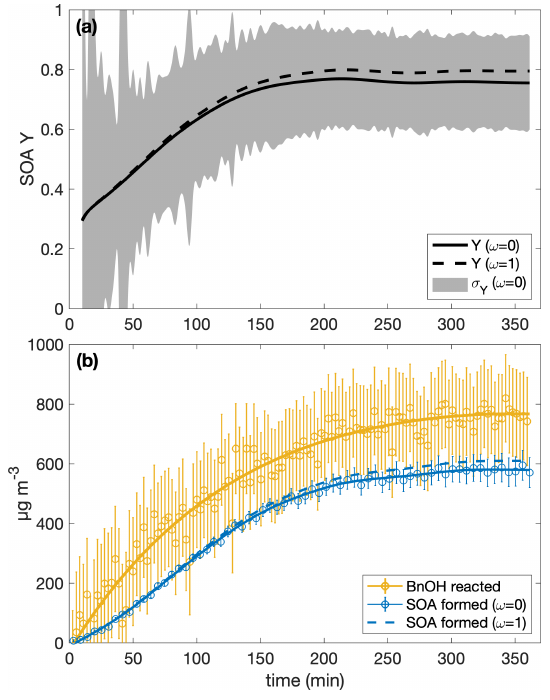
Figure 1. (a) The SOA yield for experiment R1 calculated with the assumption that ω = 0 is shown as a solid curve and with ω = 1 as a dashed one. The shaded regions indicate the associated uncer- tainty for the ω = 0 case. Due to low signal at the beginning, the first 10min of the experiment are not shown. Panel (b) shows the wall-deposition-corrected mass concentration of SOA formed as- suming ω = 0 (solid blue curve fitted to the circles and error bars) and ω = 1 (dashed blue curve). The measured mass concentration of benzyl alcohol is indicated by the yellow circles with associated error bars to which the yellow curve is